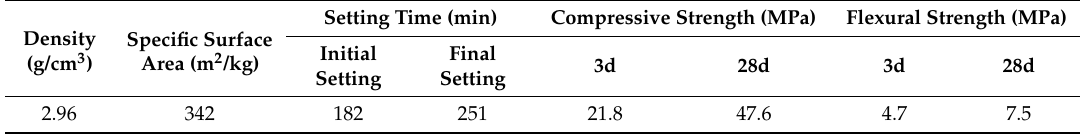
Table 2. Chemical composition of Portland cement. Table 1. Physical properties of Portland cement.